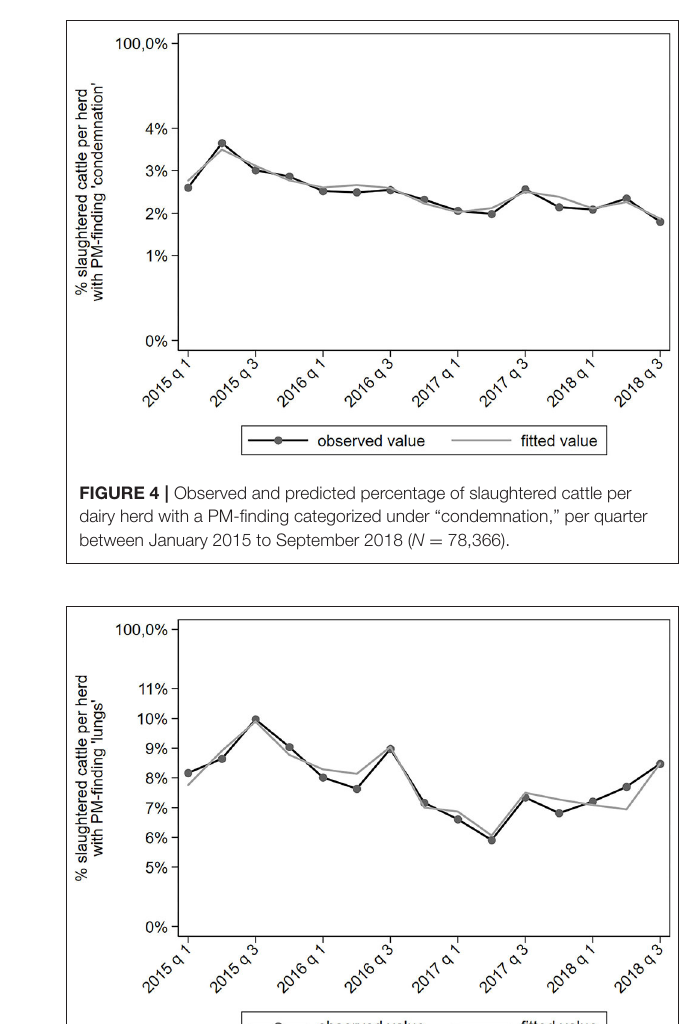
were probably biased to some extent by the location